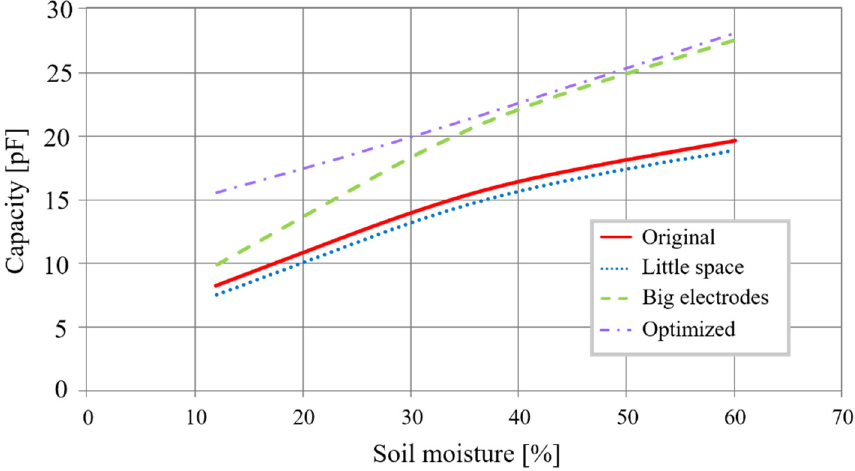
Figure 8. Comparison of the optimized design with the previous ones.